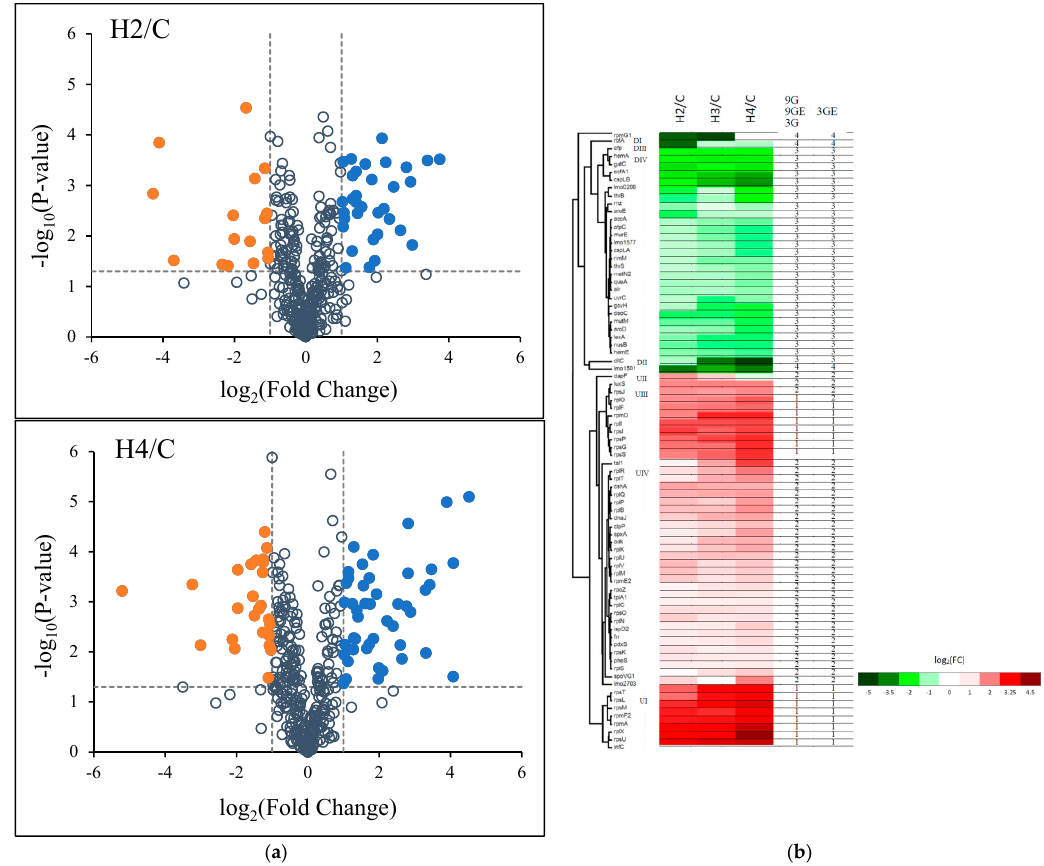
Figure 2. ( a ) Volcano plot of changes in the levels of identified L. monocytogenes proteins analyzed using label-free quantitative proteomics under the H2 and H4 treatments. Note: C, control group; H2 and H4, HPP group (200 and 400 MPa). The dashed line of y-axis is p -value = 0.05. The dashed lines of x-axis on the left and right side, respectively, are fold change = − 2 and 2. Blue dots were upregulated DEPs; orange dots were downregulated DEPs; the others were not DEPs. ( b ) Hierarchical clustering heatmap of differentially expressed proteins (DEPs) of the H2 and H4 treatments. The rows represent individual proteins with gene name on the right of each corresponding row. Red bars indicate upregulated proteins and green bars indicate downregulated proteins. The k-means clustering algorithm identified the 9G, 9GE, 3G and 3GE